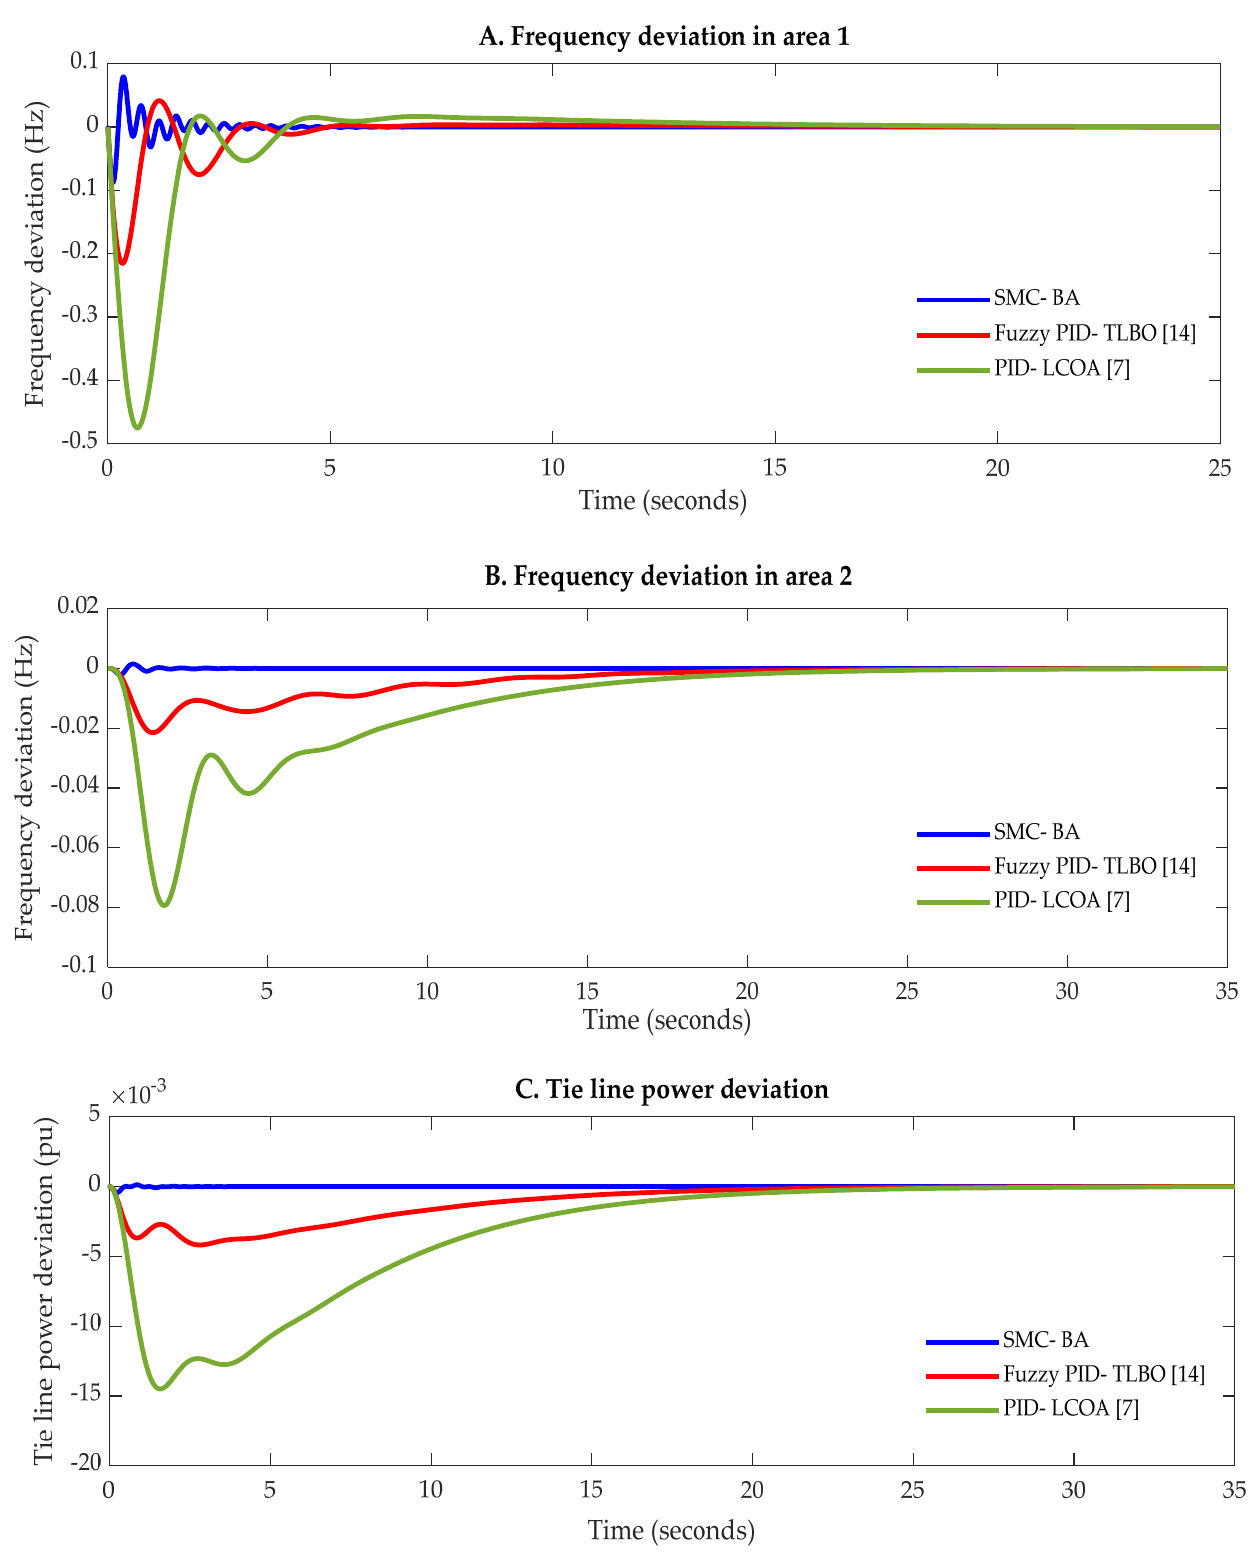
Figure 13. Dynamic response of the system with different controllers under parametric uncertainties, case 7. ( A ) Frequency deviation in area 1; ( B ) Frequency deviation in area 2; ( C ) Tie line power deviation.